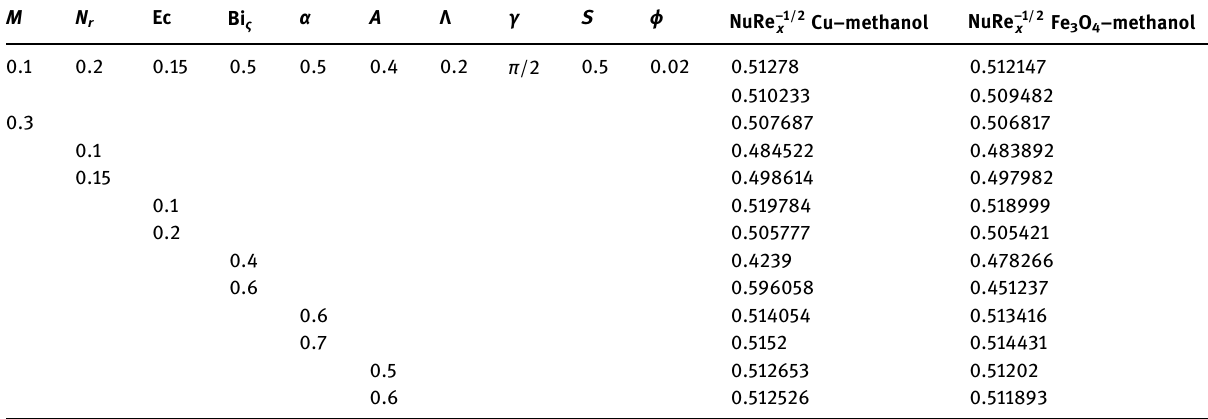
Table 4: In fl uence of varied dimensional parameters on Nusselt